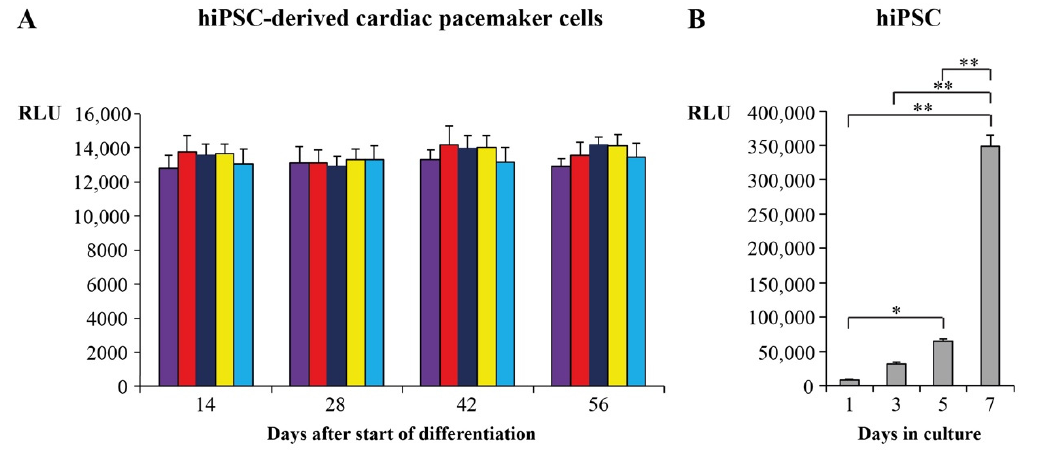
Figure 2. ATP-based cell proliferation assays. ( A ): hiPSC-derived cardiac pacemaker cells differentiated by protocols A (violet), B (red), C (dark blue), D (yellow) and E (blue). ( B ): hiPSC. Data are provided as means ± SEM. * p < 0.05, ** p < 0.01. Abbreviations: hiPSC = human induced pluripotent stem cells, RLU = relative light units, ATP = adenosine triphosphate.